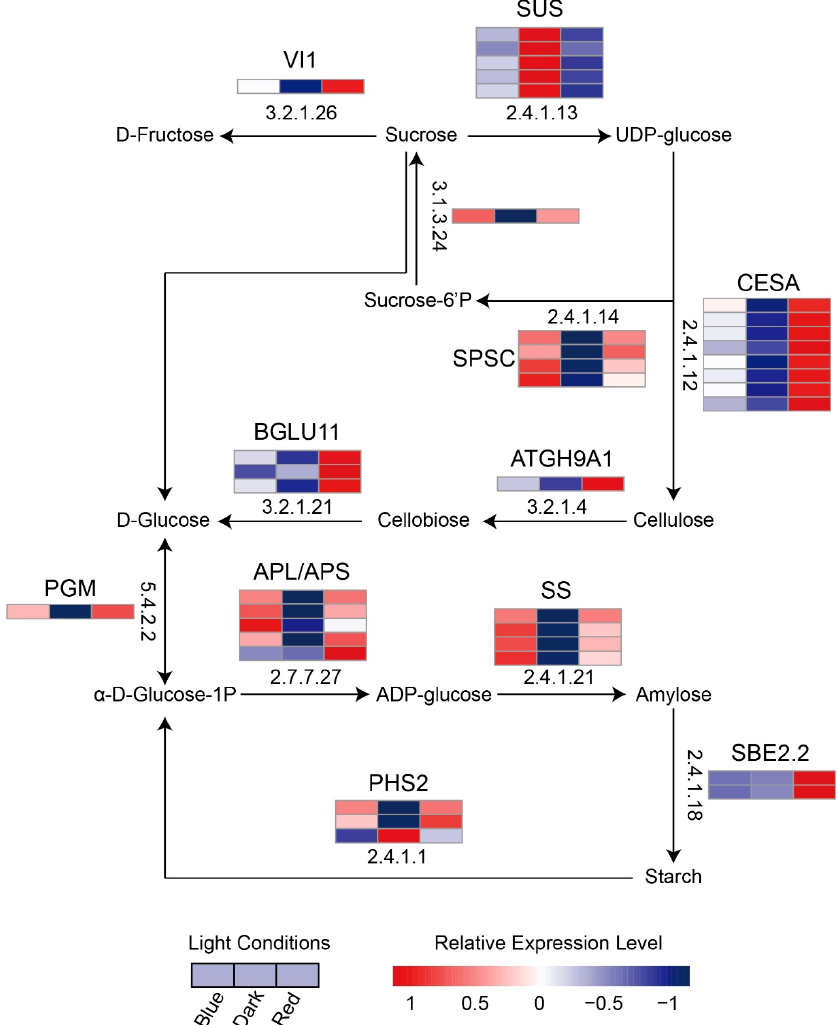
Figure 7. Expression differences in the starch and sucrose metabolic KEGG pathway-related DEPs of moso bamboo seedlings under different light treatments. The arrows indicate the direction of substrate transformation. The numbers in the boxes represent the EC numbers of the enzymes involved in the reactions. Heat maps were used to indicate the expression levels of the DEPs encoding the enzymes. (EC:3.2.1.26), beta-fructofuranosidase; (EC:2.4.1.13), sucrose synthase; (EC:2.4.1.12), cellulose synthase (UDP-forming); (EC:3.2.1.4), endoglucanase; (EC:3.2.1.21), beta-glucosidase; (EC:5.4.2.2), phosphoglucomutase; (EC:2.7.7.27), glucose-1-phosphate adenylyltrans-